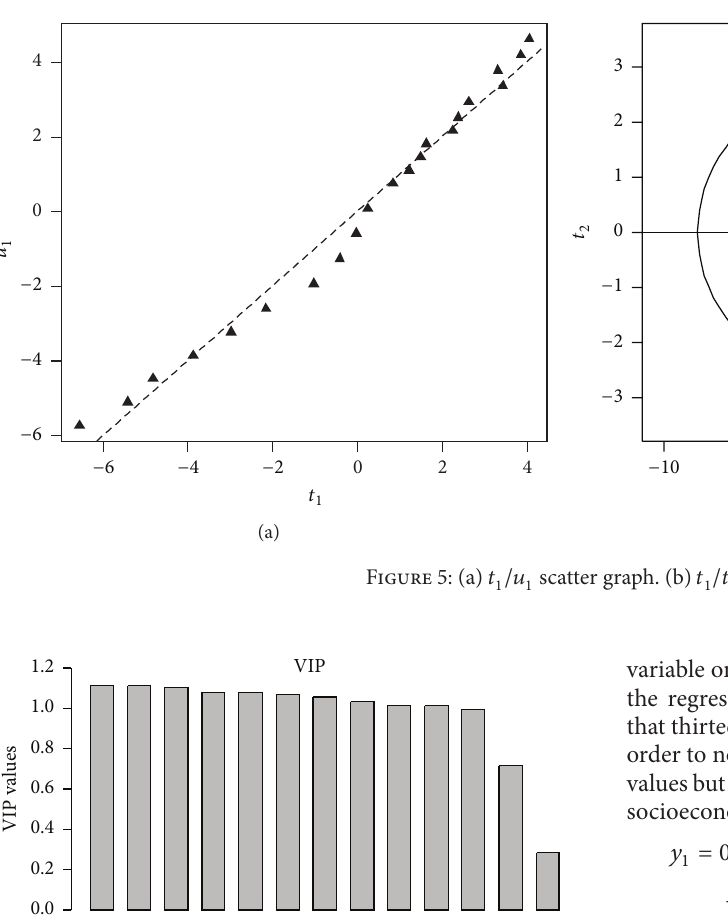
Figure 6: The VIP histogram of each